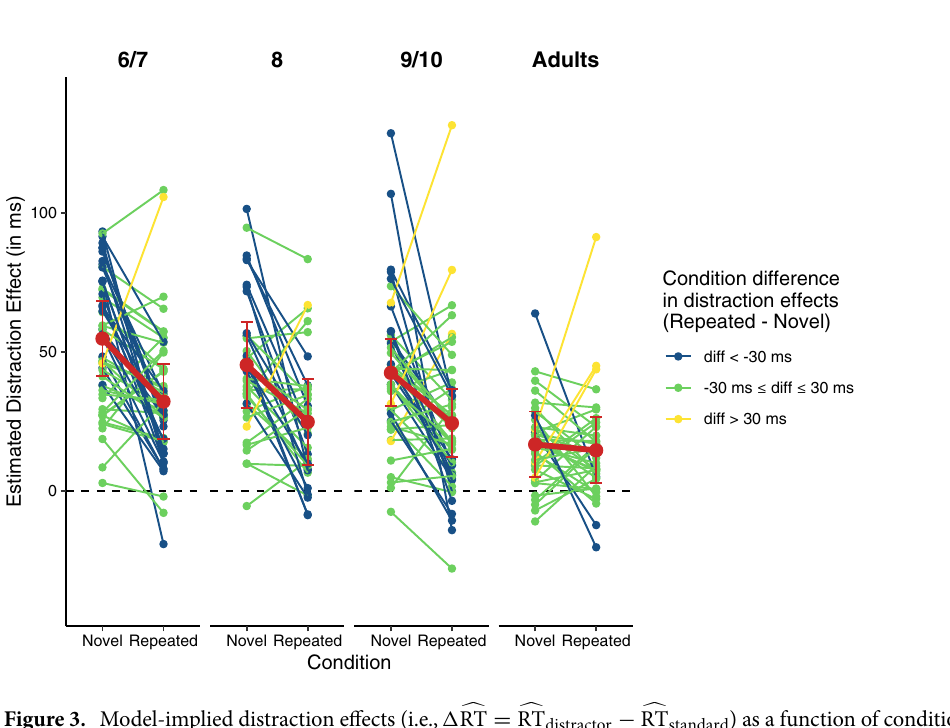
Figure 3. Model-implied distraction effects (i.e., (cid:31) and age group. The bold red lines represent the fixed effects (i.e., the ‘average’ distraction effect across participants). Error bars represent 95% confidence intervals. The thinner lines represent the distraction effects of individual participants. The color code reflects size and direction of the difference in the distraction effects between the novel and the repeated condition (i.e., (cid:31)